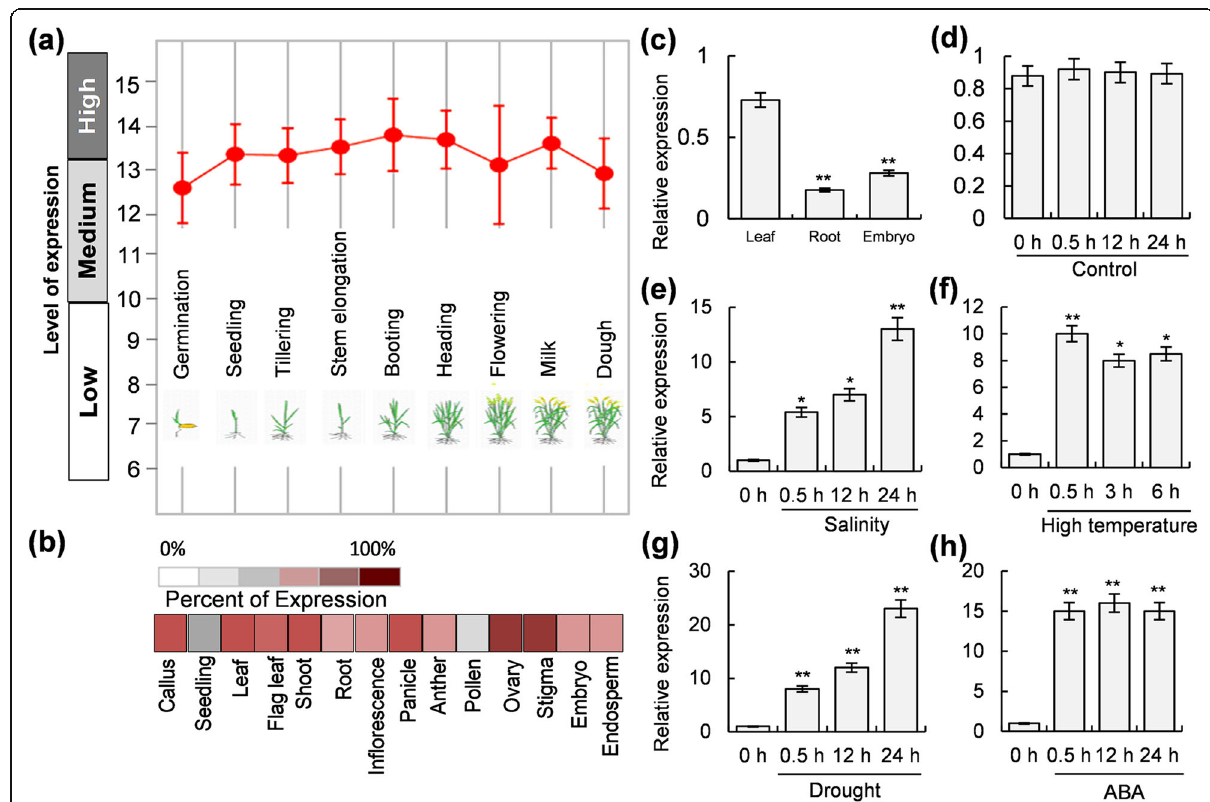
Fig. 1 Transcript expression pattern for OsHBP1b during different stages of development, in different plant tissues and under different stress conditions in rice. a Transcript expression pattern of OsHBP1b at different stages of development during the lifecycle of rice based on publicly available microarray data (www.genevestigator.com). b Expression pattern of OsHBP1b was analysed in different tissue of rice plant based on publicly available microarray data (www.genevestigator.com). c Tissue specific expression analysis of OsHBP1b in rice was analyzed through quantitative real-time PCR. Expression pattern for OsHBP1b was analyzed under control ( d ) and different abiotic stress ( e ; salinity, f ; high temperature, g ; drought, h ; ABA) treatments with increase in duration of stress period. Expression of eEF2 (housekeeping gene) was taken as control. Error bars show standard error from triplicate experiments. Single asterisk show significant difference at p < 0.005 and double asterisk at p <